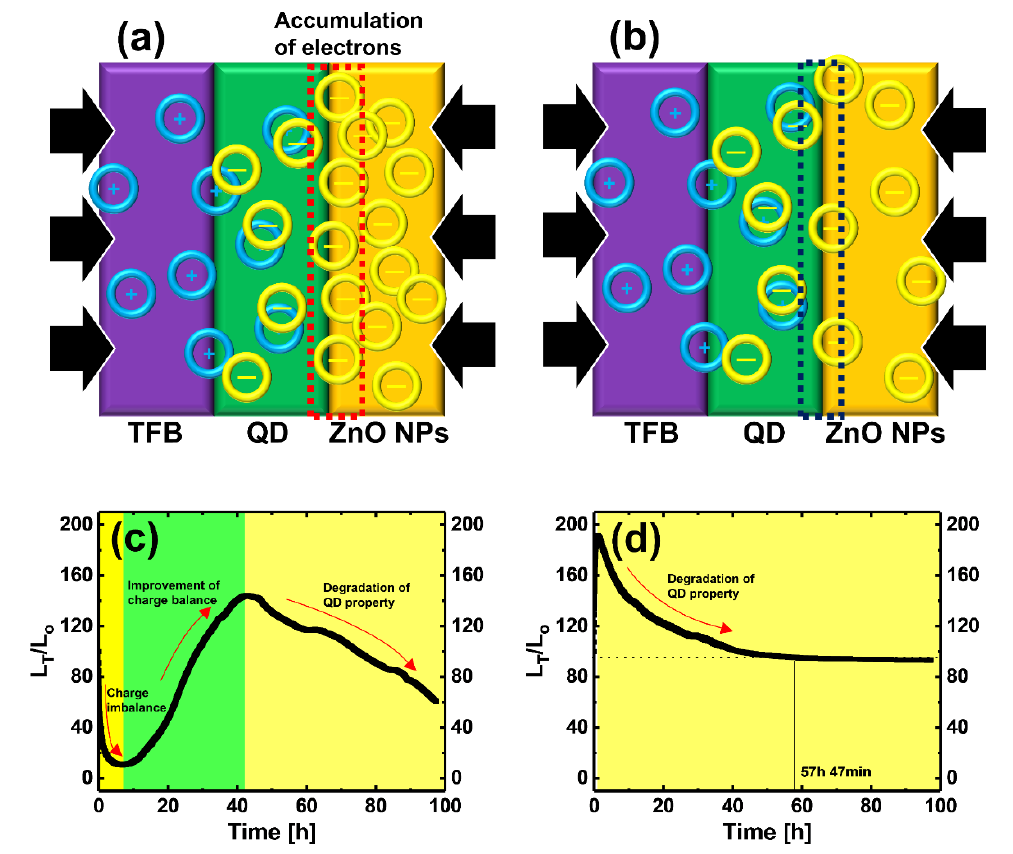
Figure 5. Schematics of interfaces between TFB and QD and QD and ZnO NPs of QLEDs ( a ) without and ( b ) with IPL post-treatment. Lifetime measurement of the QLEDs ( c ) without and ( d ) with IPL post-treatment.